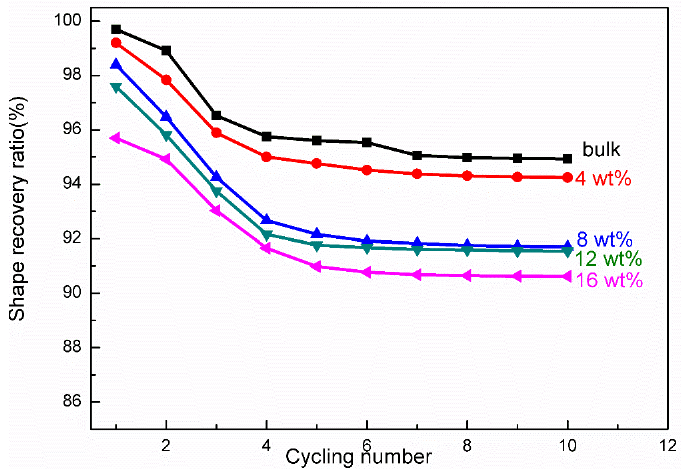
Figure 10. Effects of cycling number on recovery ratio of SiCw/hydro-epoxy composites.